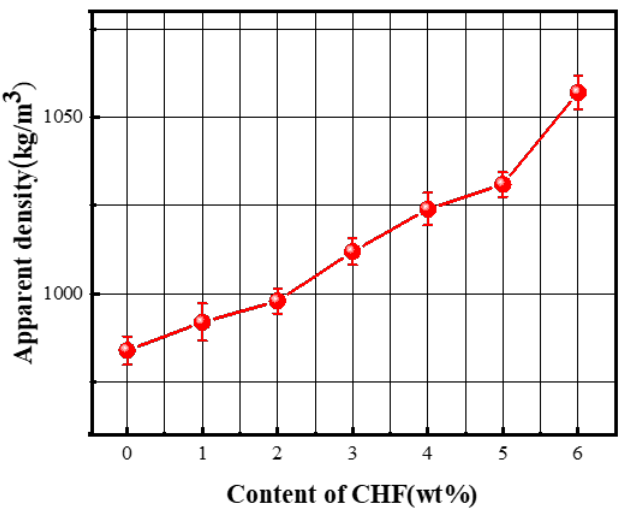
Figure 12. Influence of the content of CHF on the apparent density of the